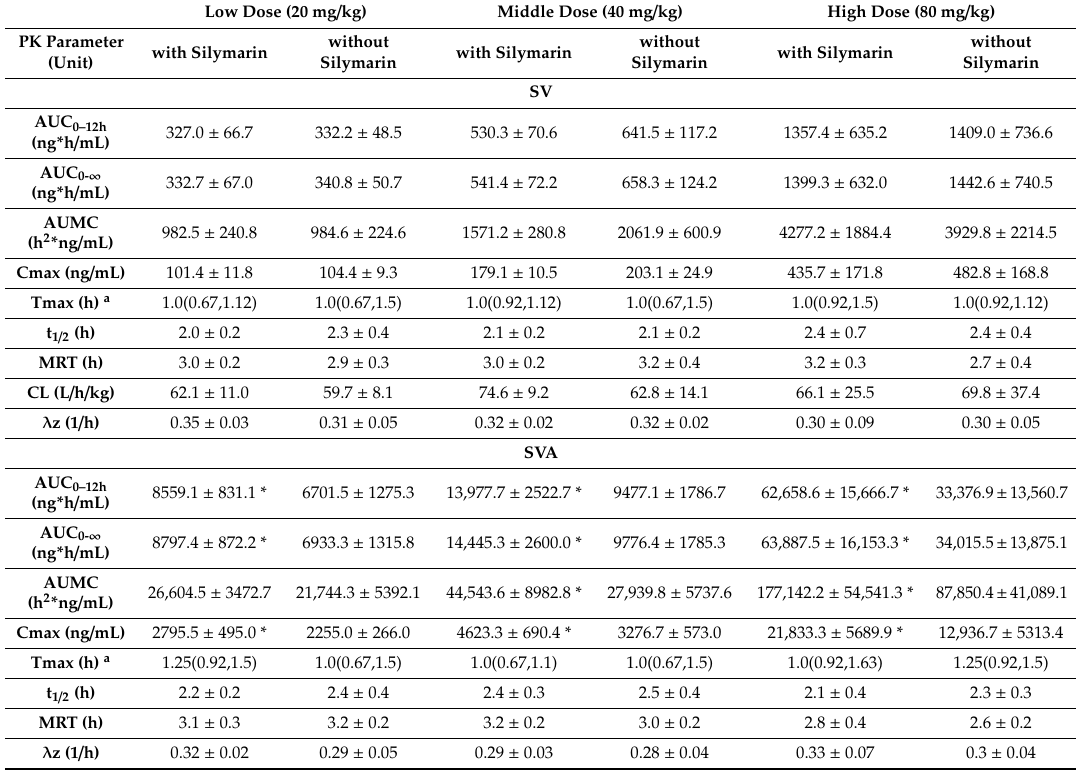
Figure 4. The pharmacokinetic profiles of SV in rats after oral administration of different doses of SV with or without treatment with silymarin (45 mg/kg). ( A ) Dose of SV at 20 mg/kg; ( B ) dose of SV at 40 mg/kg; ( C ) dose of SV at 80 mg/kg. Table 6. The pharmacokinetic parameters of SVA and SV in rats after oral administration of different doses of SV (20, 40 and 80 mg/kg, n = 6) with or without silymarin. Low Dose (20 mg/kg) Middle Dose (40 mg/kg)